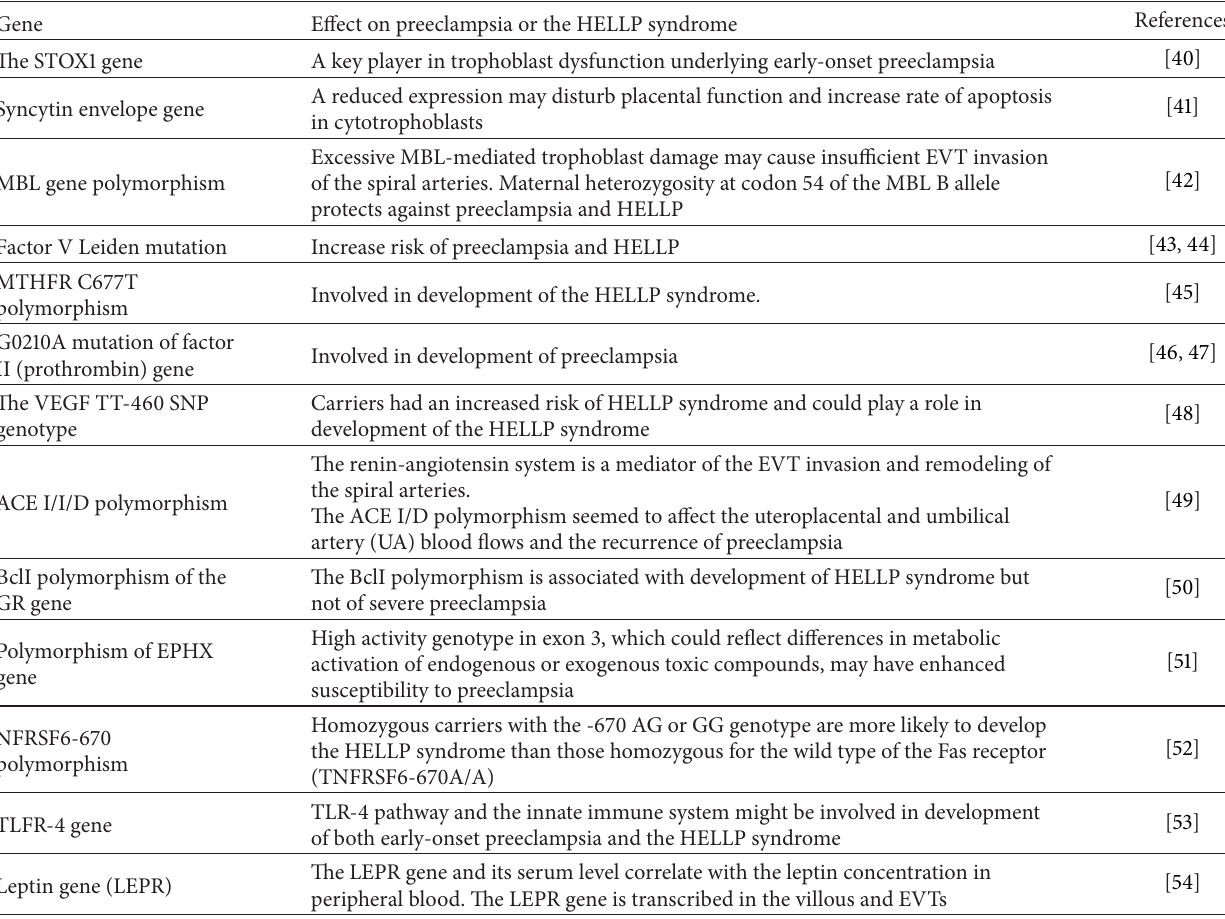
Table 1: Gene types connected to preeclampsia and the HELLP syndrome-mode of